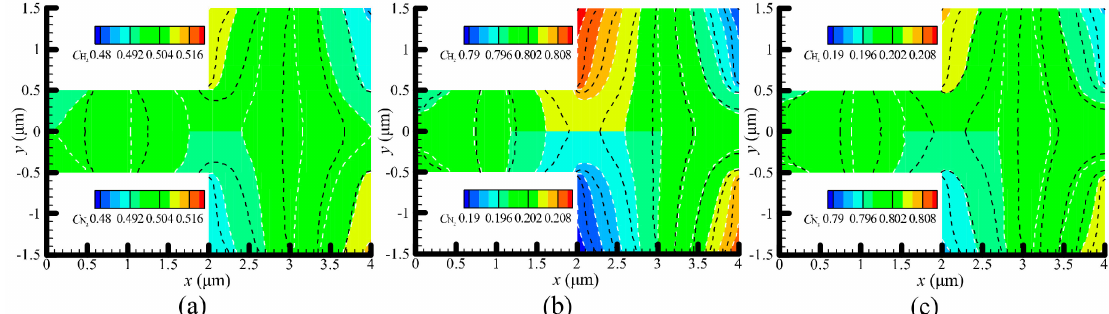
Figure 7. Concentration contours of H 2 and N 2 at P = 71.495 kPa. ( a ) N 2 :H 2 = 1:1, ( b ) N 2 :H 2 = 1:4, ( c ) N 2 :H 2 = 4:1. Dotted black lines: VSS model, while dotted white lines with colored background: VHS model. In each of the sub-figure, the top half ( y > 0) shows the concentration of H 2 , ( y < 0) shows the concentration of N 2 .